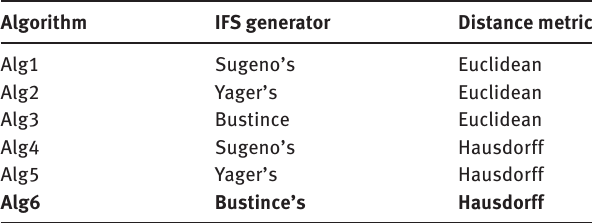
Table 1: Algorithms for Comparison.